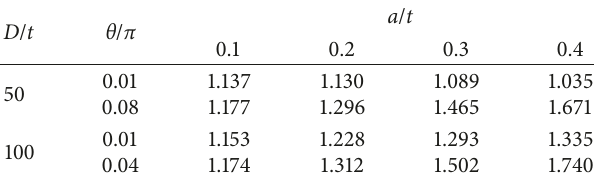
0.4 and (cid:31) Figure 5: Comparison of J -integral values for thin-walled pipes under tension with D / t Table 1: Tabulated values of F for thin-walled pipes under